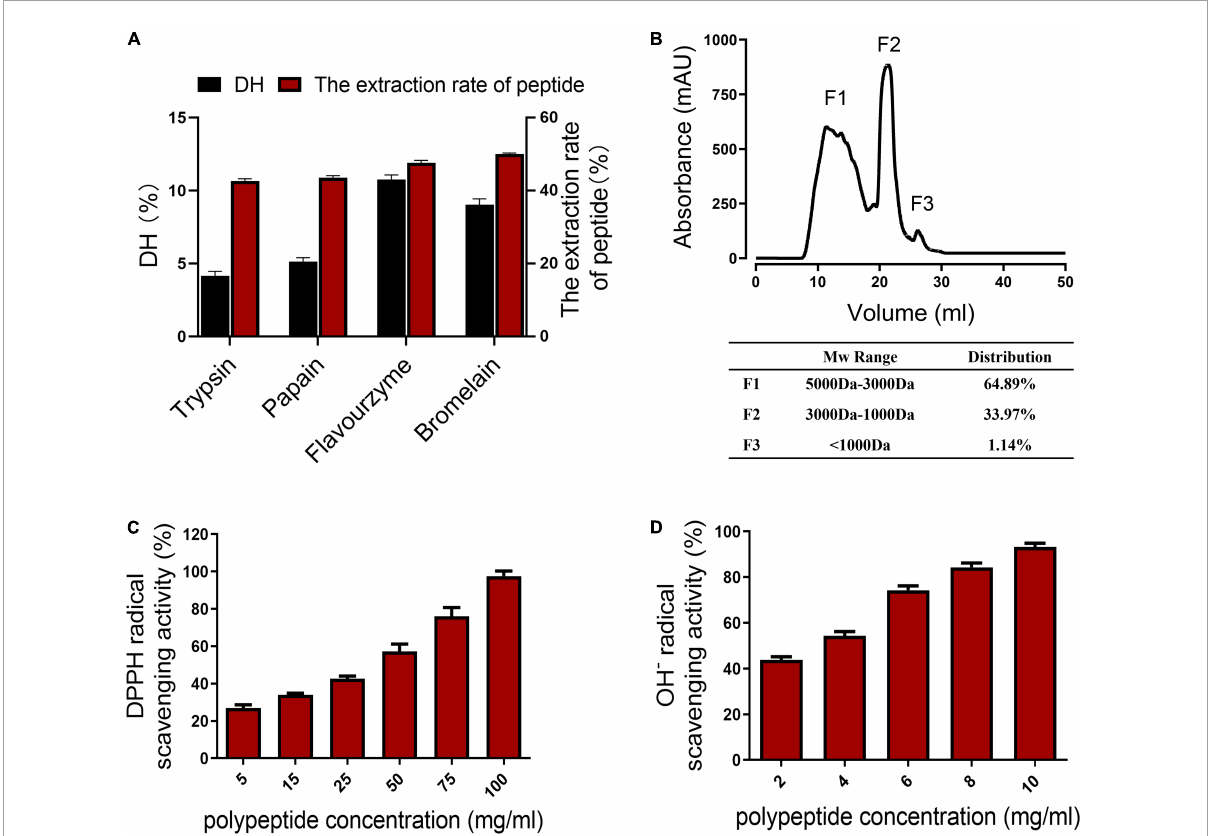
FIGURE1 Properties of the chicken skin collagen peptides (CCP). (A) Degree of hydrolysis (DH) of the collagen hydrolysates produced by trypsin, papain, flavourzyme, and bromelain. (B) The molecular weight profiles of the chicken skin collagen hydrolysates were determined by the size-exclusion chromatography. The molecular weights of the CCP are smaller than 5 kDa. (C) DPPH radical scavenging activity of the CCP. The clearance of CCP to DPPH free radicals is concentration dependent. (D) The clearance of CCP to OH − is concentration